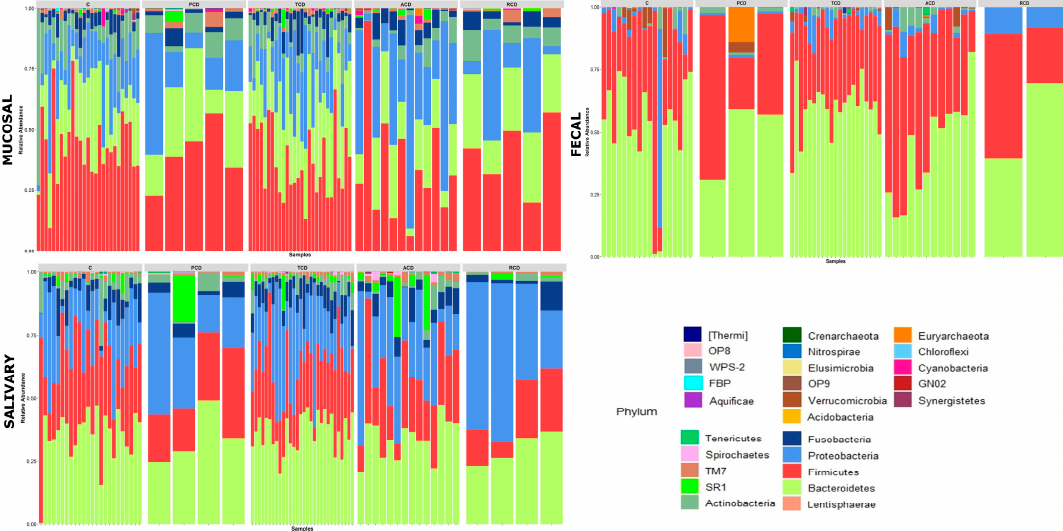
Figure 1. Phylum-level classification of bacteria identified in individual mucosal, salivary, and fecal samples belonging to the five study groups: Each bar represents the relative contribution of phylum-level profiles of each subject enrolled in the study as indicated on the top of each panel (ACD: active celiac disease, C: control subjects, PCD: potential celiac disease, RCD: refractory celiac disease, and TCD: treated celiac disease). Twenty-six different phyla were identified across the three biotypes and are represented by different colors as indicated in the legend. The relative distribution of phyla among study groups indicates a critical decrease of Firmicutes and Actinobacteria and an expansion of Proteobacteria at mucosal and salivary levels in all celiac groups, mostly in ACD and RCD, in comparison with the C group that does not normalize in TCD. By contrast, no clear di ff erences are evident in the